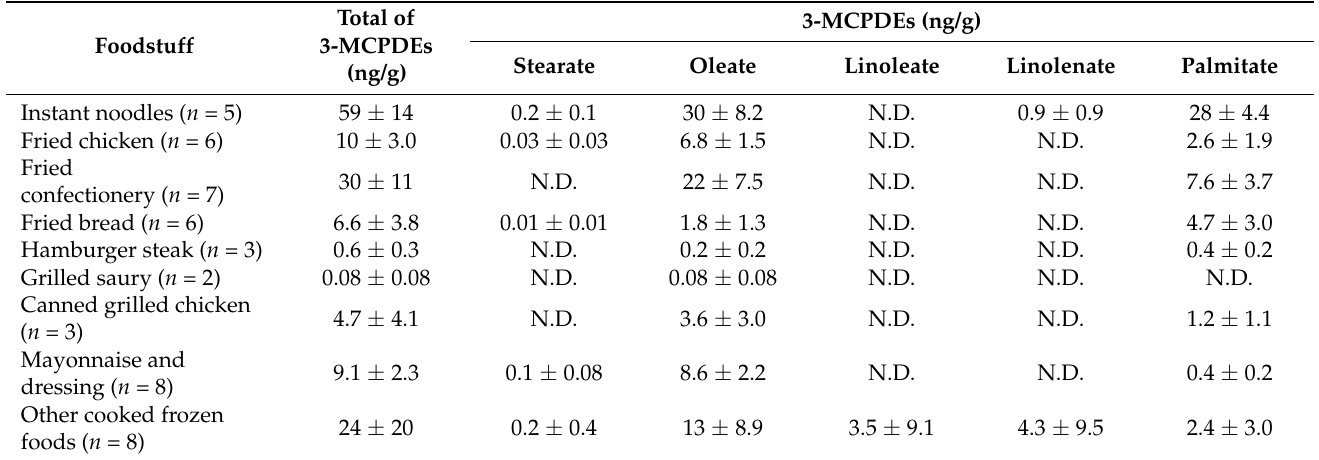
Table 4. Concentration of 3-MCPDEs in food samples from eight food categories.